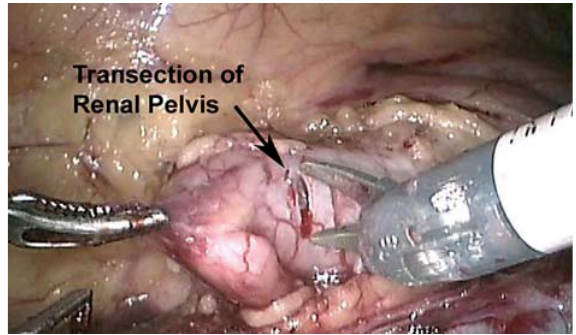
Figure 4 – Transection of renal